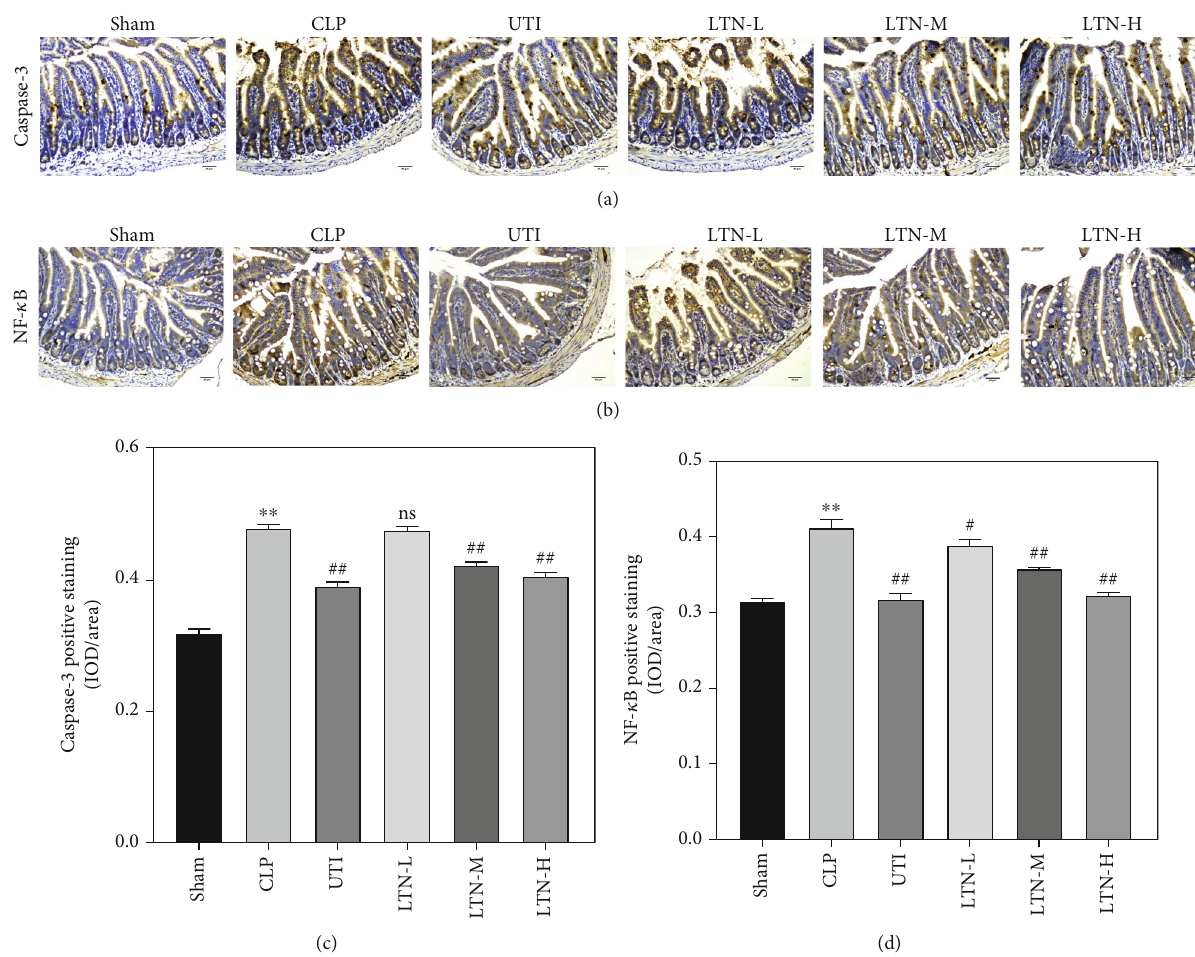
Figure 5: Lentinan inhibits the apoptosis of intestinal epithelial cells and decreases the expression of NF- κ B. (a) The expression of caspase-3 was detected by IHC in the small intestine of mice. (b) IHC assay of NF- κ B in the small intestine of mice. (c, d) Quantitative results of caspase-3 and NF- κ B. ∗∗ p < 0 : 01 vs. sham group. # p < 0 : 05 and ## p < 0 : 01 vs. CLP group. IOD: integrated optical